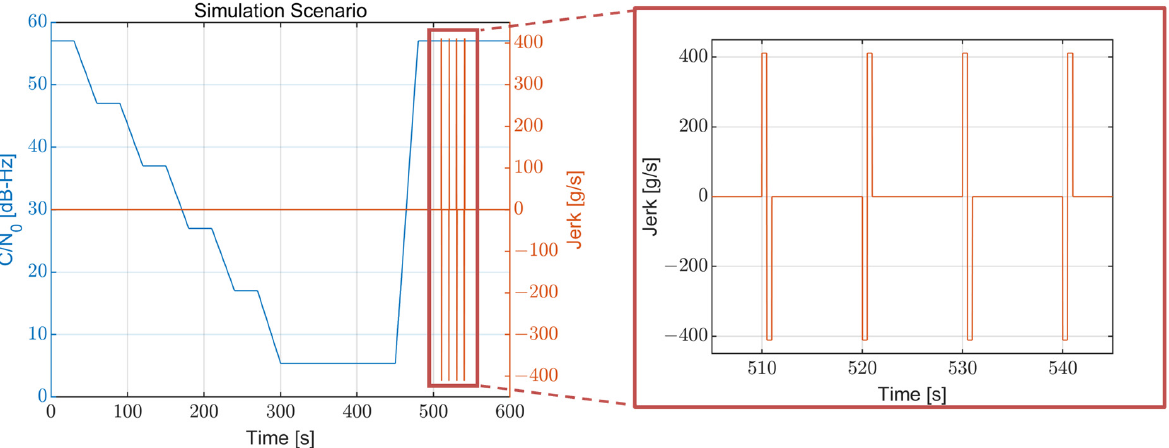
Figure 9. Configured simulation scenario information. The C/N 0 has a range of 5.4–57 dB-Hz and the maximum jerk is 411 g/s.